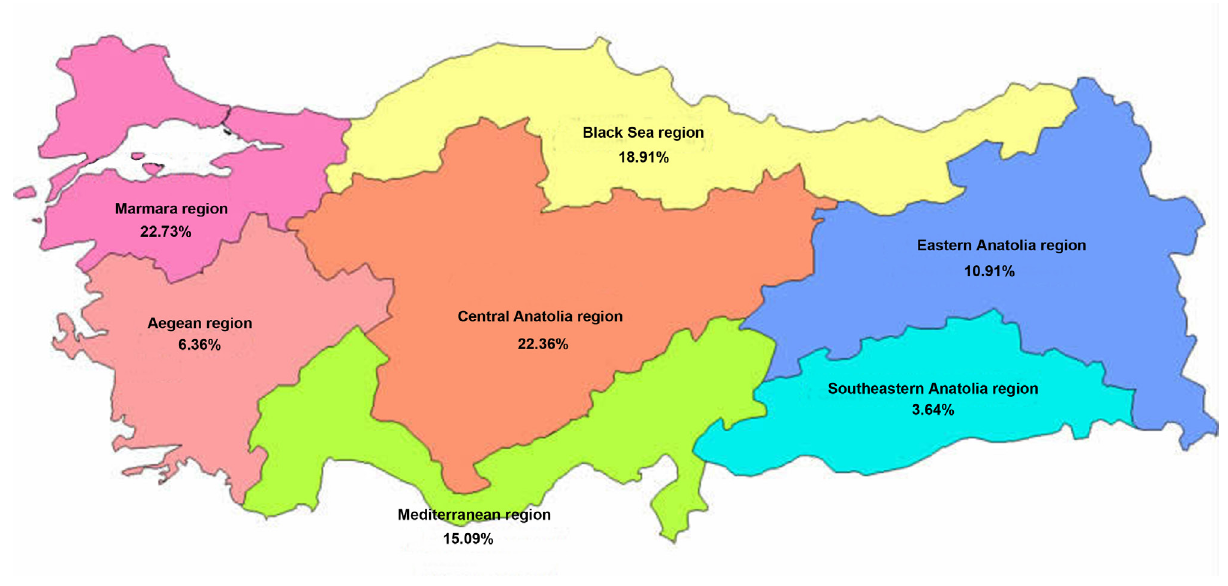
Figure 1. Distribution of snakebites according to the geographic regions of